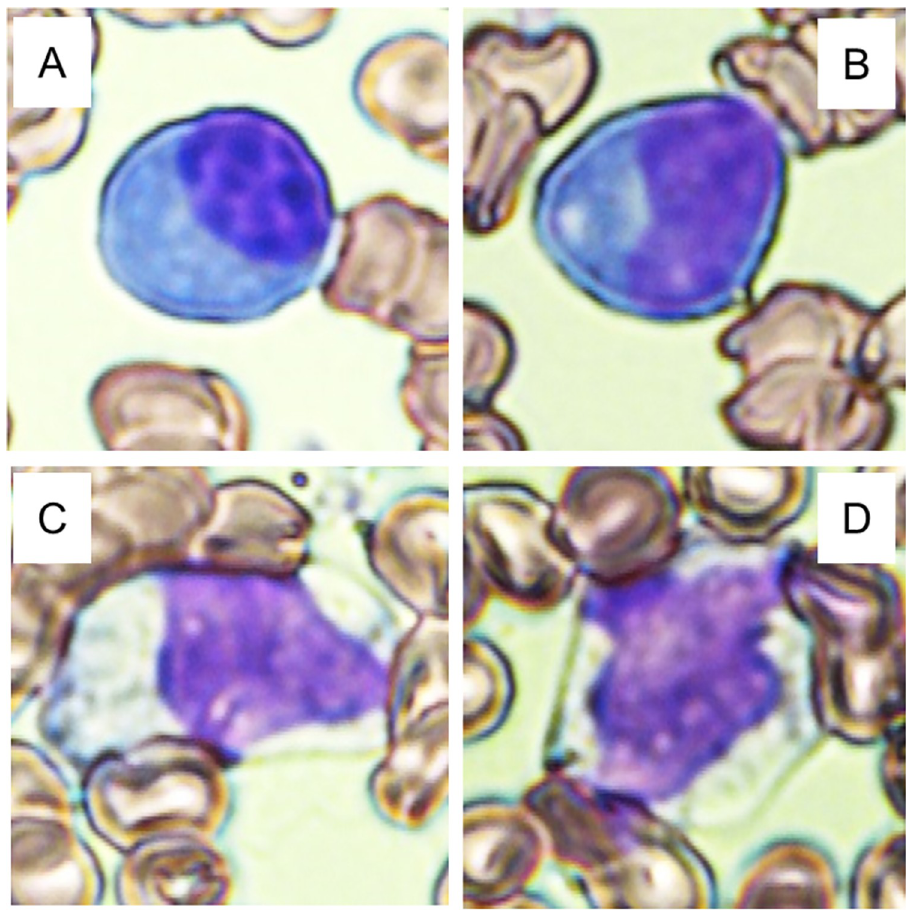
Fig 1. Representative atypical lymphocytes in the peripheral blood of COVID-19 patients. All images are of May- Giemsa-stained peripheral blood smears. (A, B) Atypical lymphocytes with condensed chromatin, deep basophilic cytoplasm and eccentric nuclei. (C, D) Atypical lymphocytes with abundant pale cytoplasm and indented nuclei, resembling Downey II cells.